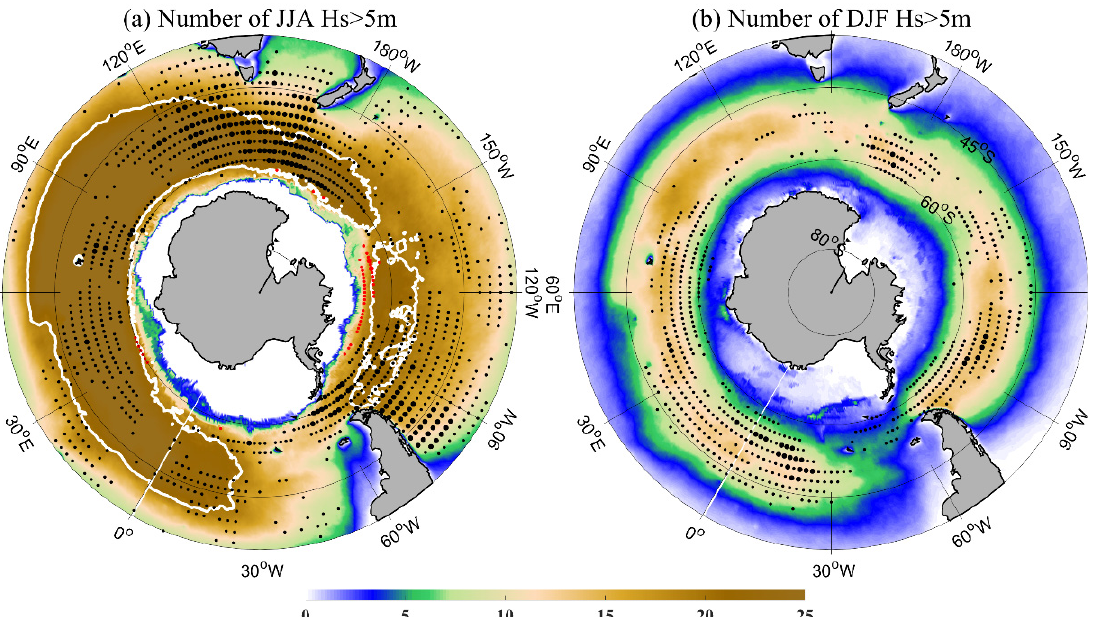
Figure 5. Similar to Figure 2, but for the number of wave processes larger than 8 m. The white con- tours show the area where the number was more than 4, the small black dots indicate where the trend was higher than 0.01 /a and less than 0.02 /a, the larger black dots show where the trend was larger than 0.02 /a, and the red dots indicate a decreasing trend with the criteria similar to those of the black dots. In conclusion, the SWH, EWH, and extreme wave processes larger than 5 m and 8 m were significantly stronger in winter than in summer. The climatology of the SWH and the statistical results of wave processes higher than 5 m all show that the intensity and frequency of waves increased in both winter and summer. The statistics of the extreme